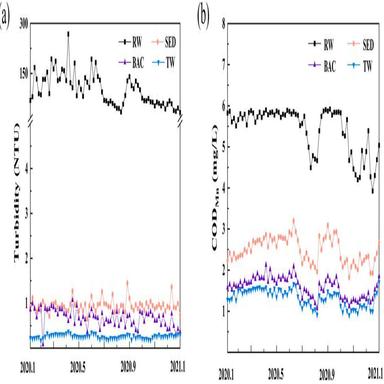
The key water quality parameters in the drinking water treatment processes. (a) Turbidity; (b) CODMn.